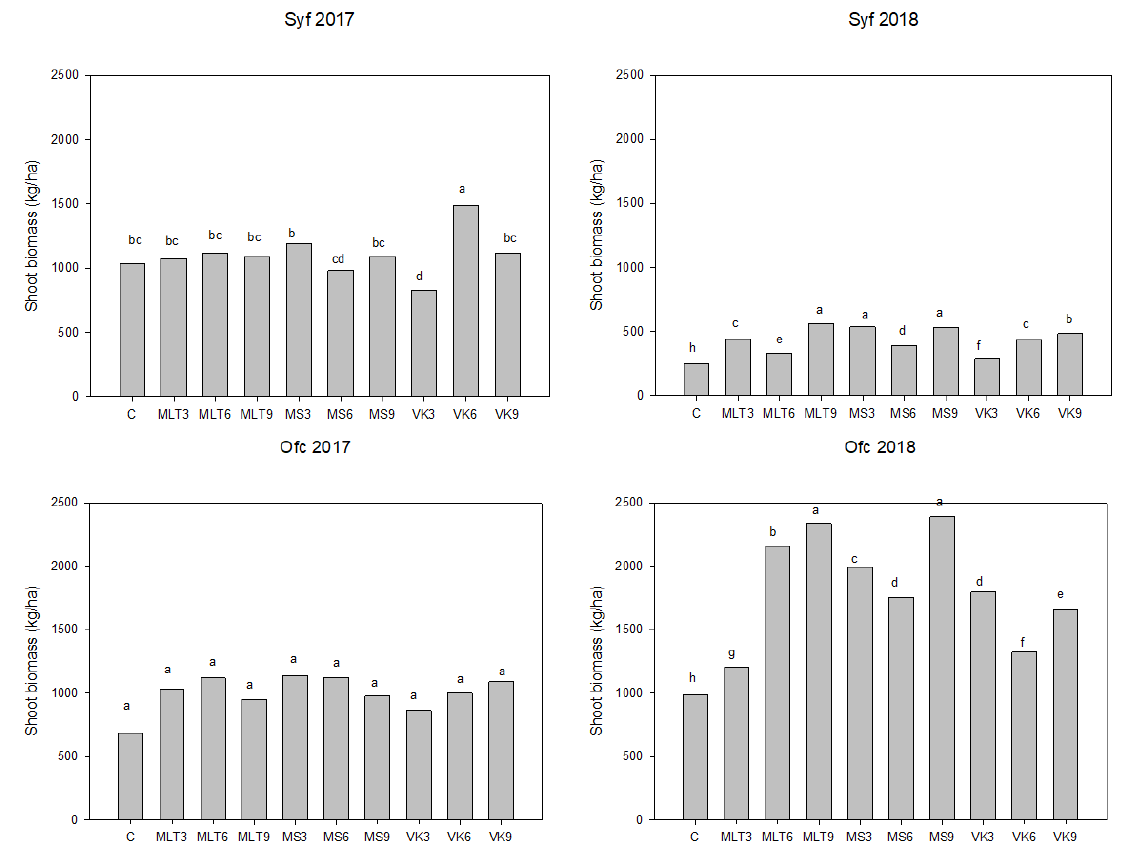
Figure 3. Shoot biomass at Syferkuil and Ofcolaco in the 2017 and 2018 seasons. MLT is Moringa Oleifera leaves and twigs applied at rates of 3 tons/ha (MLT3), 6 tons/ha (MLT6) and 9 tons/ha (MLT9); MS is M. Oleifera stems applied at rates of 3 tons/ha (MS3), 6 tons/ha (MS6) and 9 tons/ha (MS9); VK is Vachelia Karoo leaves and twigs applied at rates of 3 tons/ha (VK3), 6 tons/ha (VK6) and 9 tons/ha (VK9). Different letters show significant differences.